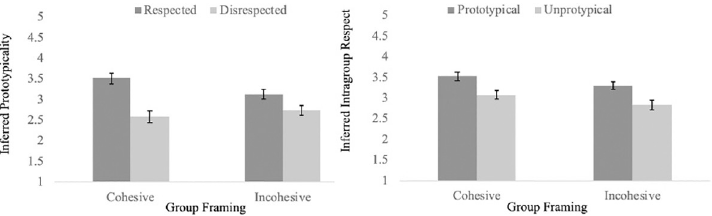
Fig 4. Inferred intragroup respect and inferred prototypicality as a function of target prototypicality or target intragroup respect in high powered replication studies.